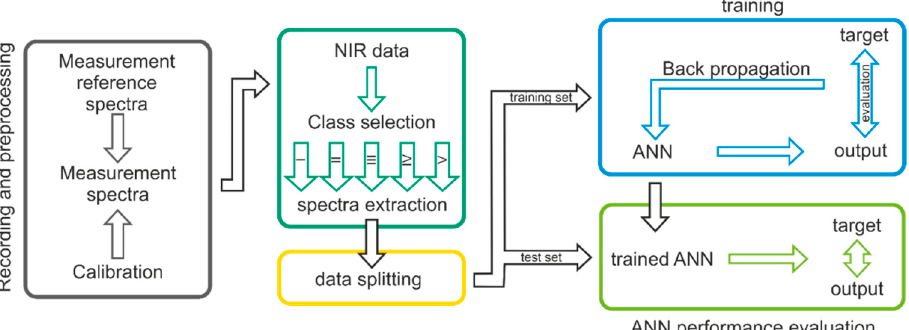
Figure 2. Schematic representation of the study approach: the procedure was based on extracting hyperspectral NIR information by utilizing a deep-learning-based model applying ANN.